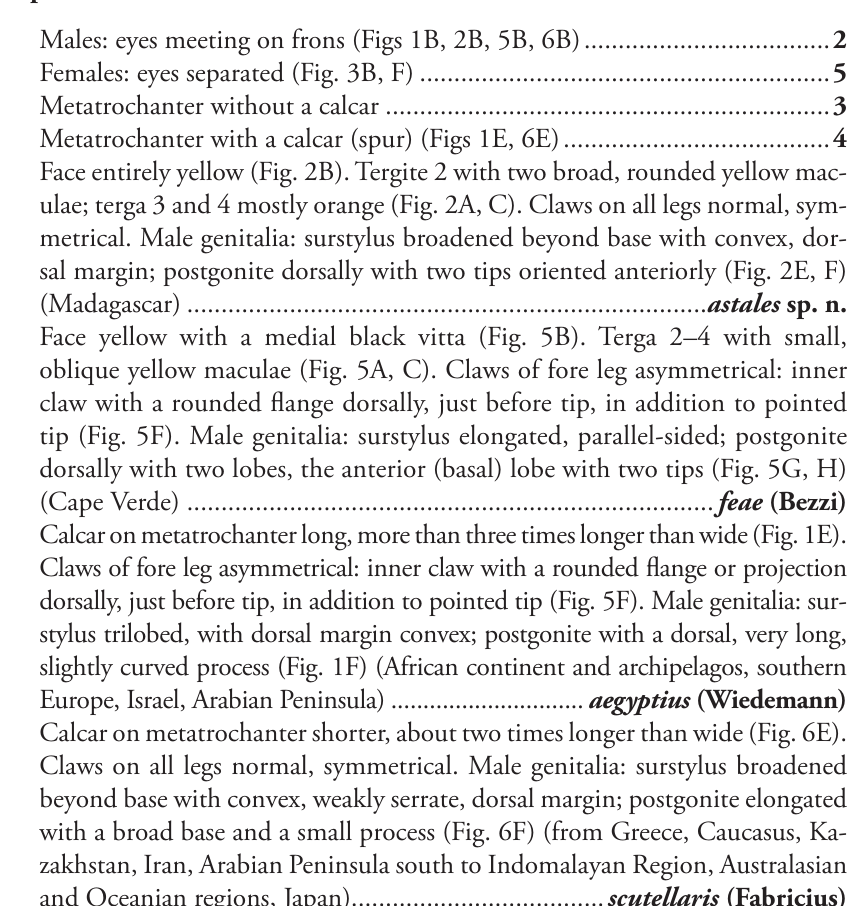
Metatrochanter without a calcar ................................................................. 3 Metatrochanter with a calcar (spur) (Figs 1E, 6E) ....................................... 4 Face entirely yellow (Fig. 2B). Tergite 2 with two broad, rounded yellow mac- ulae; terga 3 and 4 mostly orange (Fig. 2A, C). Claws on all legs normal, sym- metrical. Male genitalia: surstylus broadened beyond base with convex, dor- sal margin; postgonite dorsally with two tips oriented anteriorly (Fig. 2E, F) (Madagascar) ............................................................................ astales sp. n. – Face yellow with a medial black vitta (Fig. 5B). Terga 2–4 with small, oblique yellow maculae (Fig. 5A, C). Claws of fore leg asymmetrical: inner claw with a rounded flange dorsally, just before tip, in addition to pointed tip (Fig. 5F). Male genitalia: surstylus elongated, parallel-sided; postgonite dorsally with two lobes, the anterior (basal) lobe with two tips (Fig. 5G, H) (Cape Verde) ............................................................................. feae (Bezzi) 4 Calcar on metatrochanter long, more than three times longer than wide (Fig. 1E). Claws of fore leg asymmetrical: inner claw with a rounded flange or projection dorsally, just before tip, in addition to pointed tip (Fig. 5F). Male genitalia: sur- stylus trilobed, with dorsal margin convex; postgonite with a dorsal, very long, slightly curved process (Fig. 1F) (African continent and archipelagos, southern Europe, Israel, Arabian Peninsula) .............................. aegyptius (Wiedemann) – Calcar on metatrochanter shorter, about two times longer than wide (Fig. 6E). Claws on all legs normal, symmetrical. Male genitalia: surstylus broadened beyond base with convex, weakly serrate, dorsal margin; postgonite elongated with a broad base and a small process (Fig. 6F) (from Greece, Caucasus, Ka- zakhstan, Iran, Arabian Peninsula south to Indomalayan Region, Australasian and Oceanian regions, Japan)..................................... scutellaris